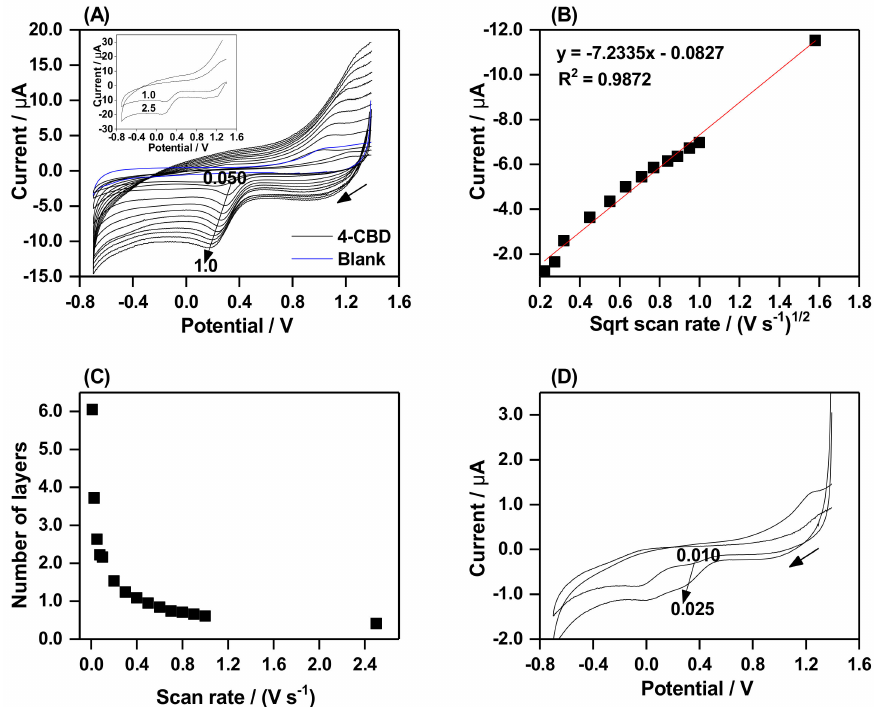
Figure 7. ( A ) CVs of 0.15 mmol / L 4-CBD (1st scan), 1.40 to -0.70 V, with various scan rates: 0.050, 0.075, 0.10, 0.20, 0.30, 0.40, 0.50, 0.60, 0.70, 0.80, 0.90, and 1.0 V.s − 1 (black lines), blank at 0.10 V.s − 1 (blue line), and inset: 1.0 and 2.50 V.s − 1 ; ( B ) peak current vs. square root of scan rate (0.050 to 2.50 V.s − 1 ); ( C ) number of layers vs. scan rate (0.010 to 2.50 V.s − 1 ); and ( D ) CVs of 0.15 mmol / L 4-CBD (1 st scan), 1.40 to − 0.70 V, at 0.010 and 0.025 V.s − 1 . Arrows in CVs show direction of